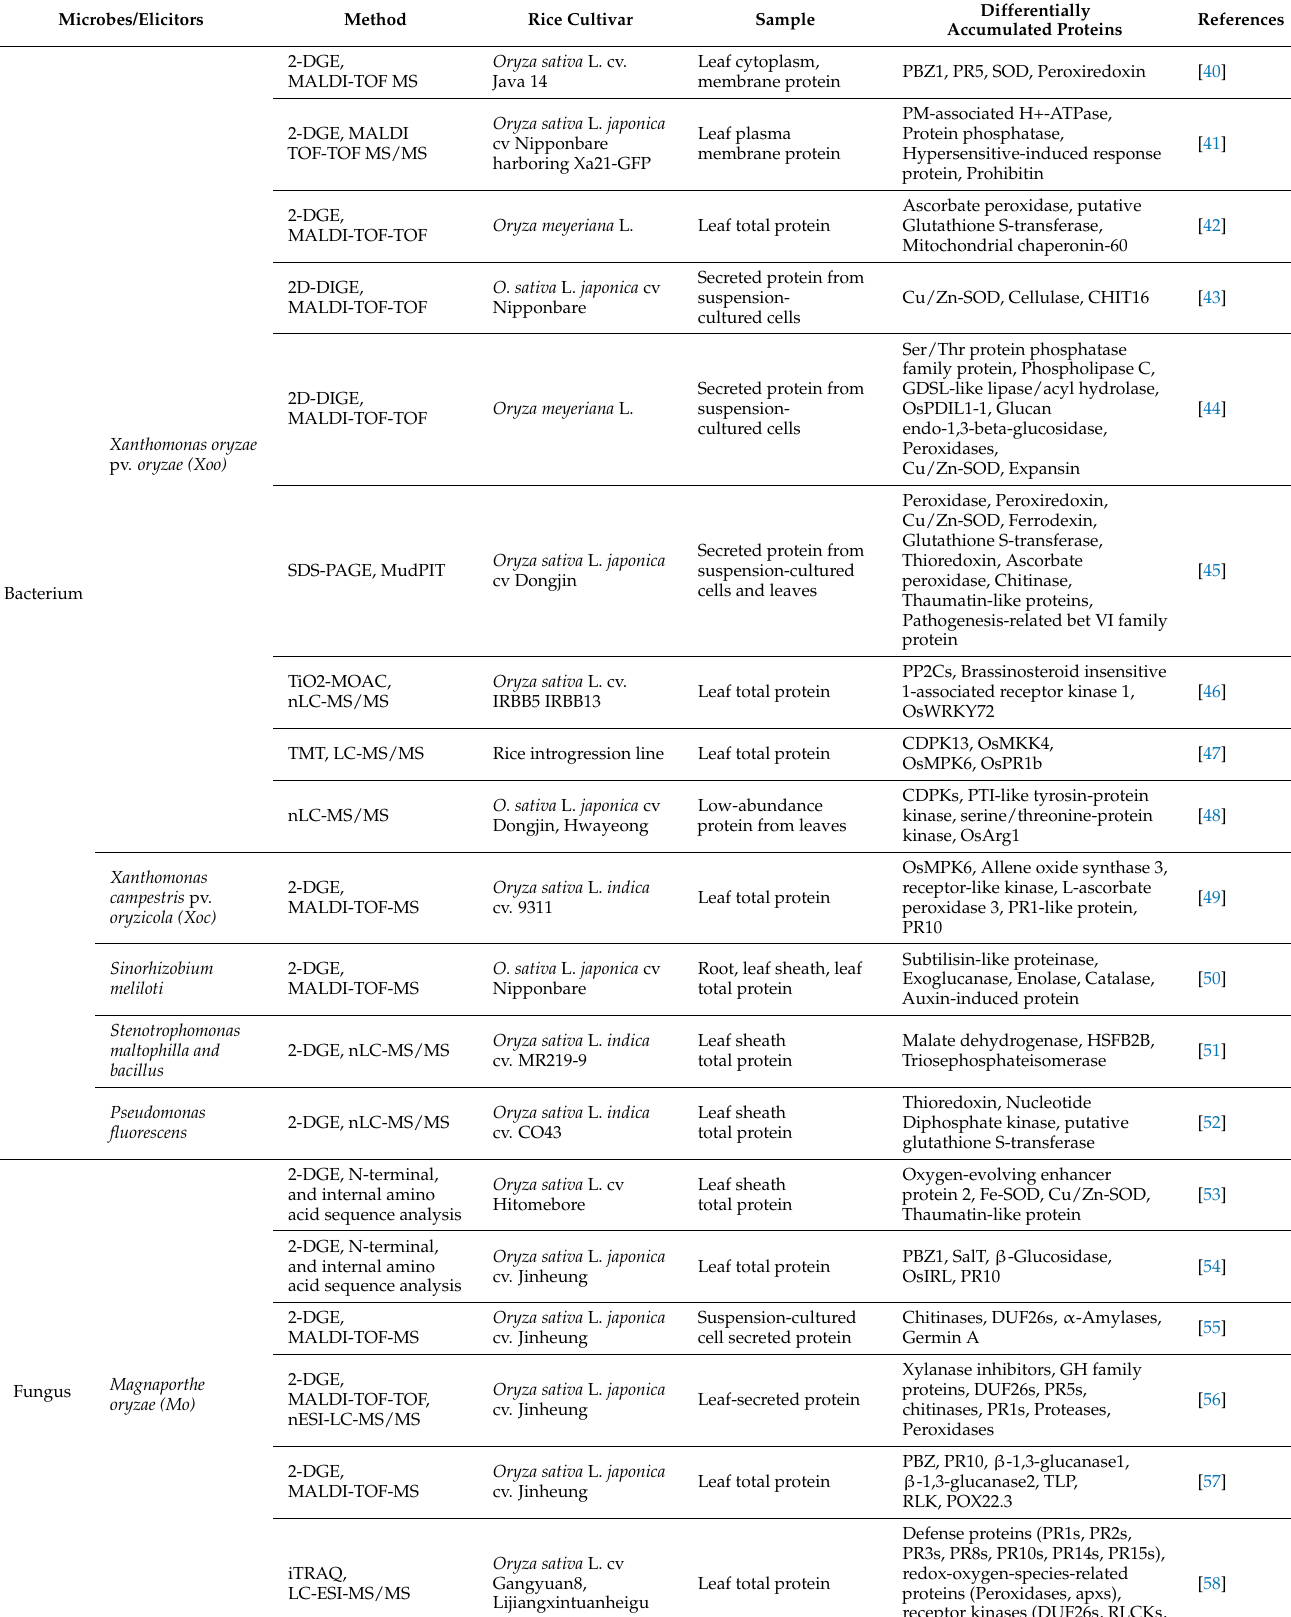
Table 1. Proteomics investigations of rice–microbe